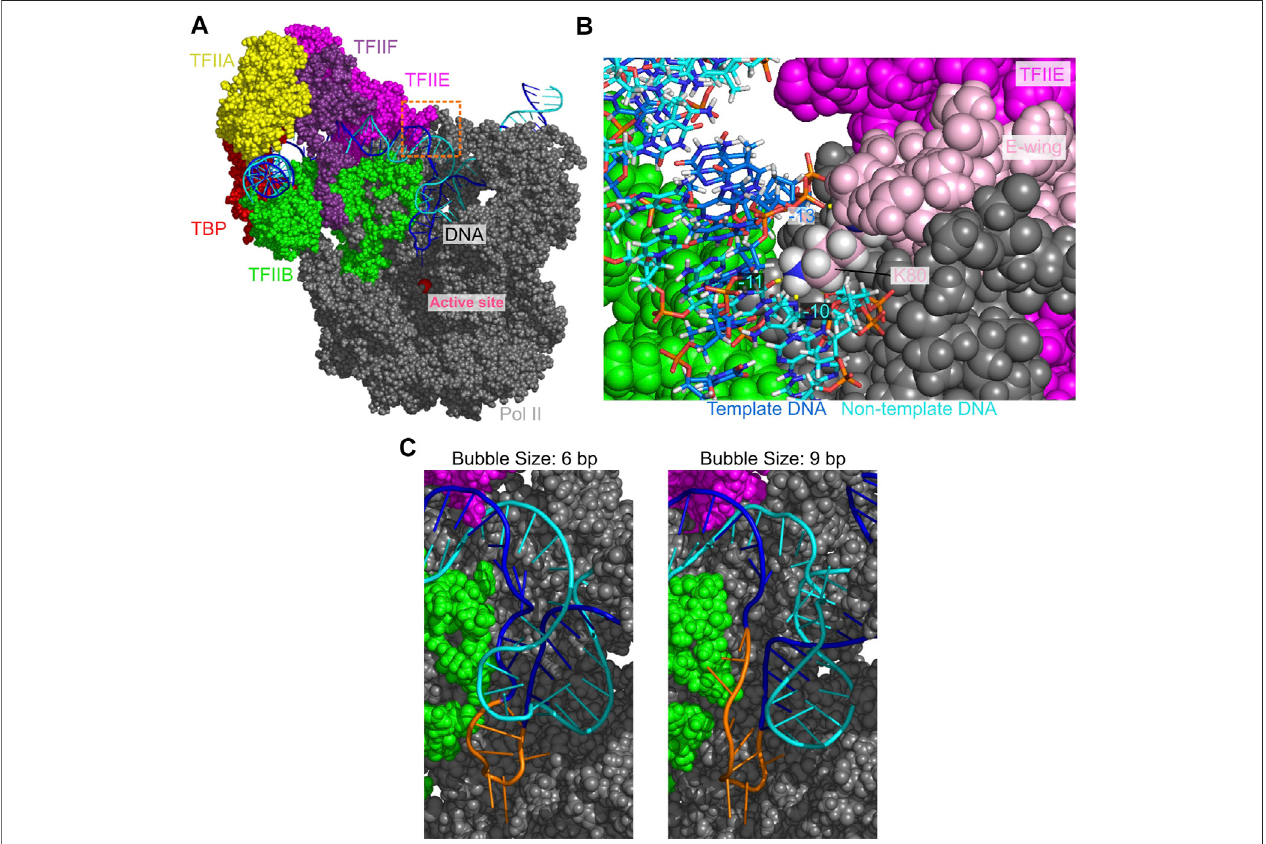
FIGURE 3 | The open DNA in the OC state of PIC. (A) Atomic structure model for the OC state. Some proteins are not displayed to make the DNA visible. (B) A close-up view of the orange dashed squared area in (A) . Pink, the E-wing of TFIIE; yellow dashed lines, hydrogen bonds between DNA and the E-wing. (C) Open DNA structures with the bubble size of 6 bp (left) and 9 bp (right) . Orange, the template DNA strand in the